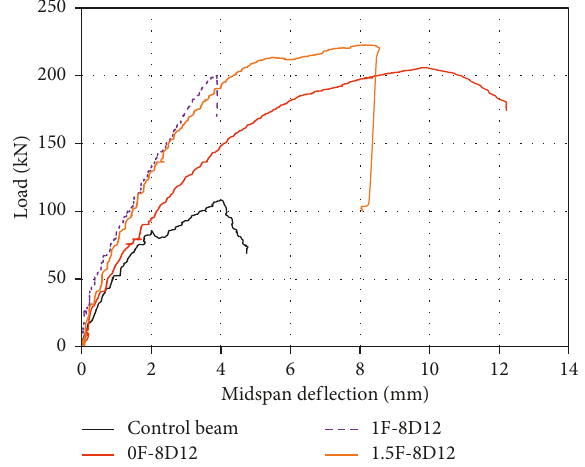
Figure 4: Load-deflection curves for beams with different steel fiber volume